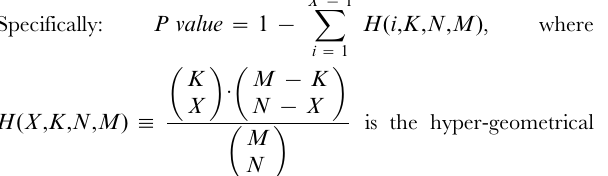
Figure S3 Dynamics of average module expression and cell growth upon environmental perturbations. The average log2- ratio-expression is presented for three ESR gene modules. Bars designate the measured cells growth rate, which is normalized relative to the steady state growth rate.